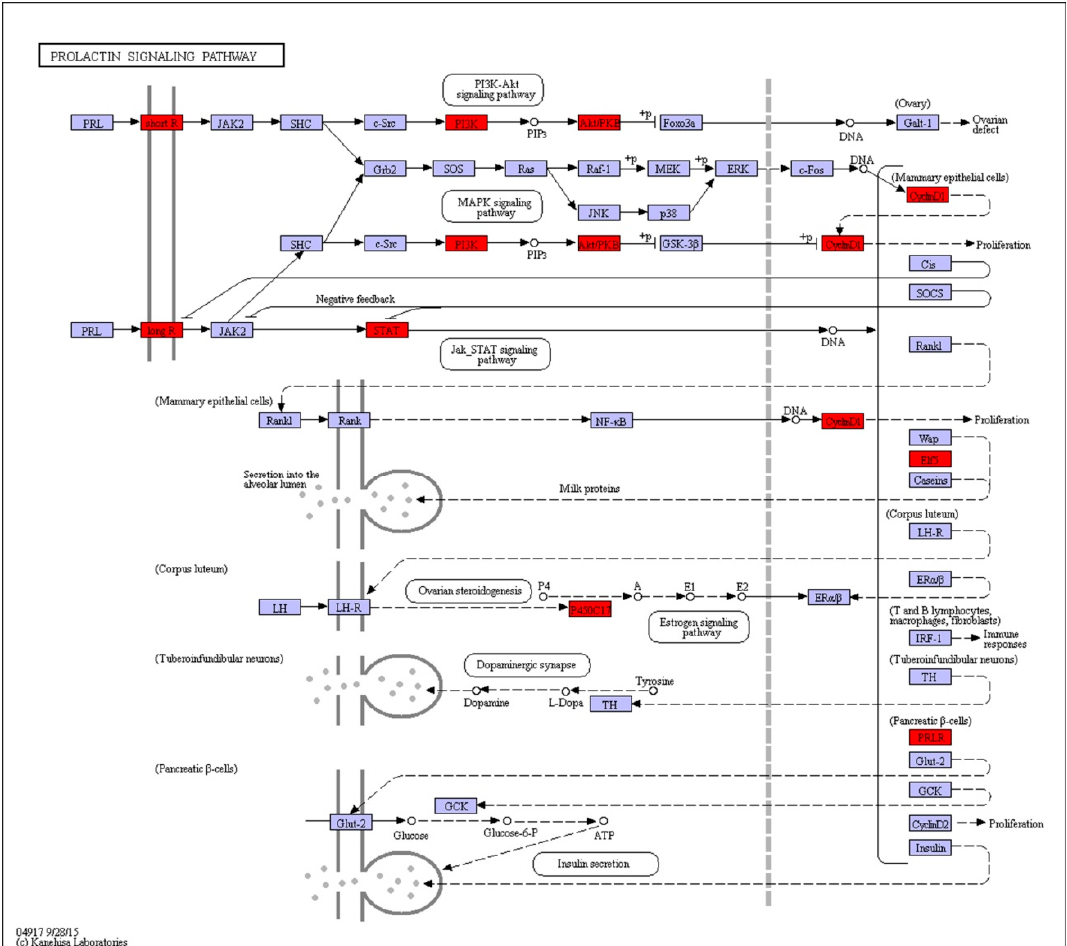
Figure 3. Model of activation of the prolactin signalling pathway in the mink uterus in activated versus diapause states. Differentially expressed genes are shown in red color. Genes in blue boxes were present in the mink transcriptome but not differentially expressed.